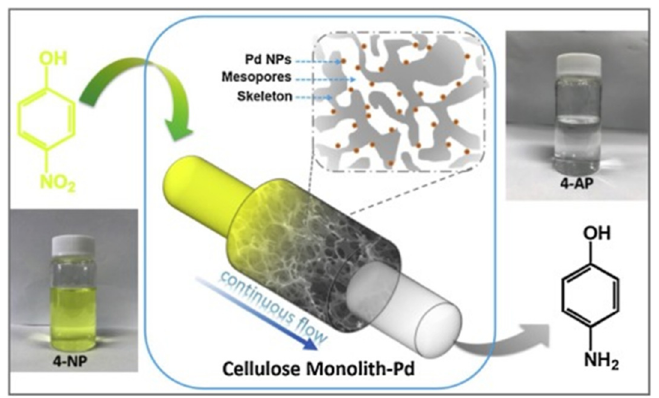
Figure 14. Reduction of yellow 4-nitrophenol (4-NP) to colorless 4-aminophenol (4-AP) in a contin- uous flow reactor filled with cellulose monolith-supported Pd NPs [106].